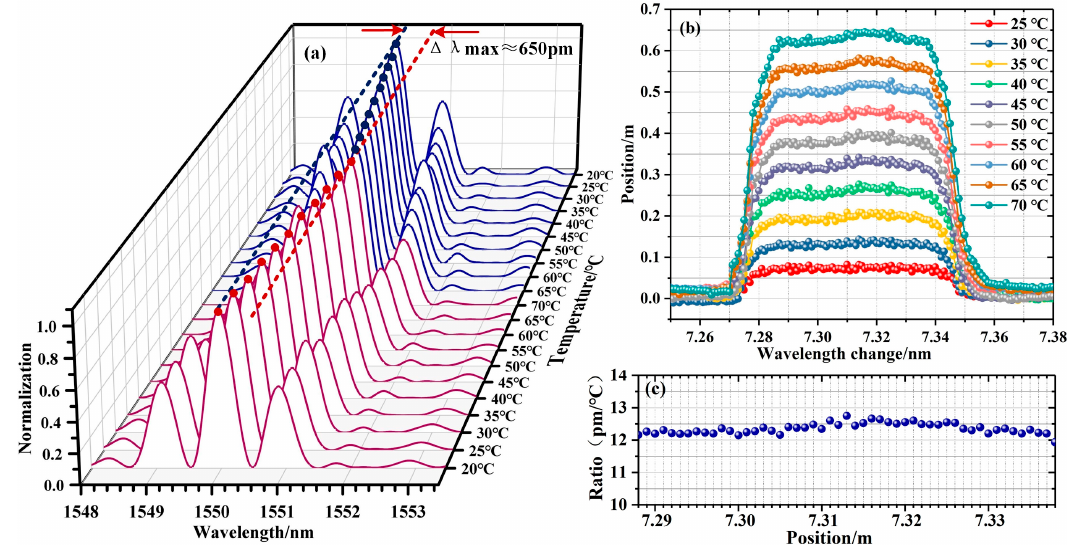
Figure 3. The distributed temperature sensing: ( a ) the reflection spectrum changes of one sensing element area in different temperature; ( b ) the wavelength changes with the temperature change; ( c ) the temperature sensitivity of each element in FBG array sensor.